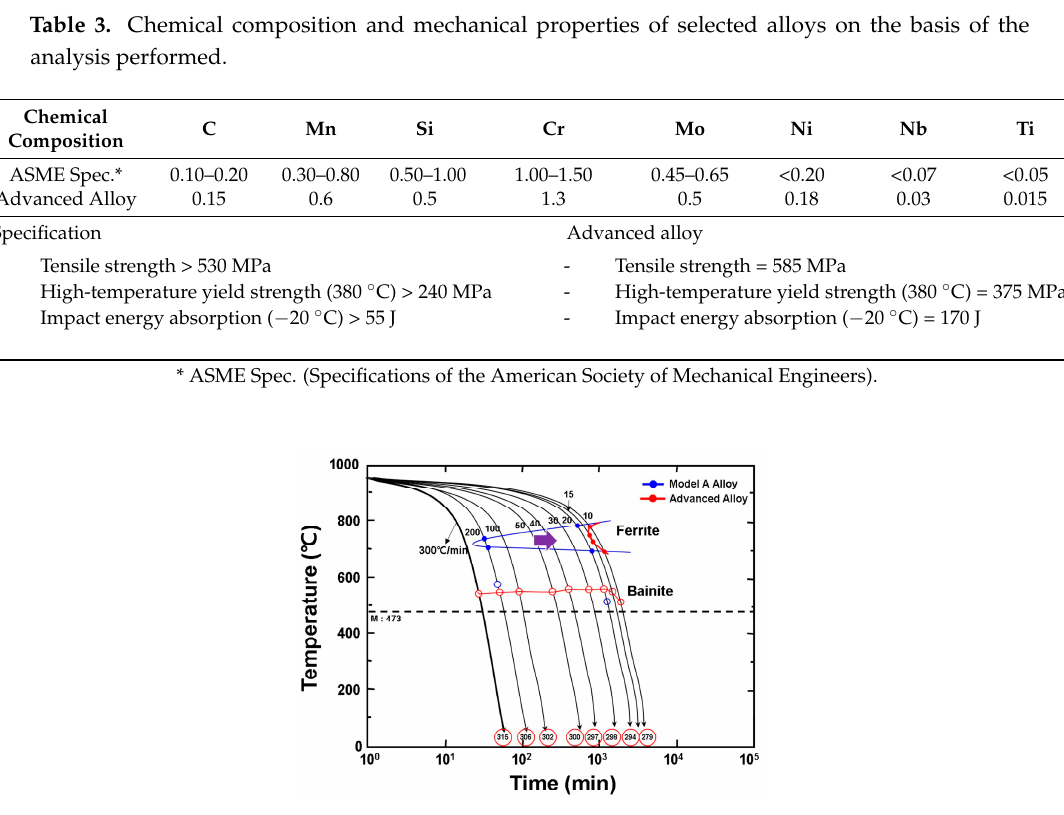
Figure 10. Continuous cooling transformation (CCT) curve of model A alloy and advanced alloy.